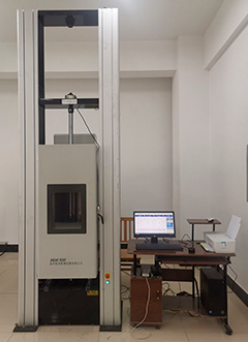
Figure 5. The electronic machine with controlled temperature. Table 2. Summary table of tensile mechanical property data of geogrids under different low temperatures. Table 1.